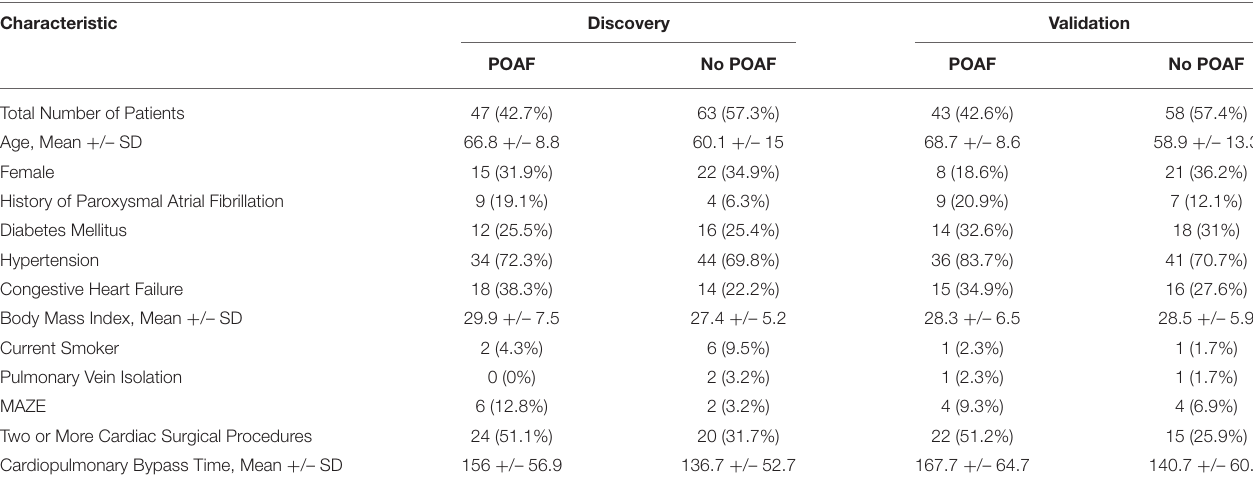
TABLE 1 | Characteristics of patient